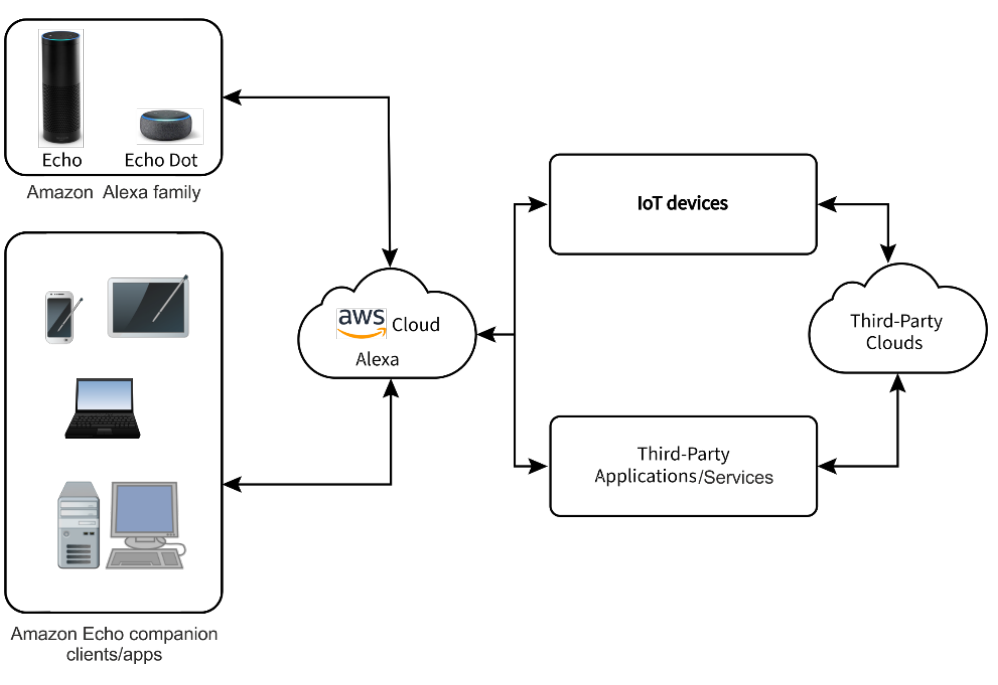
Figure 8. Amazon Alexa ecosystem.